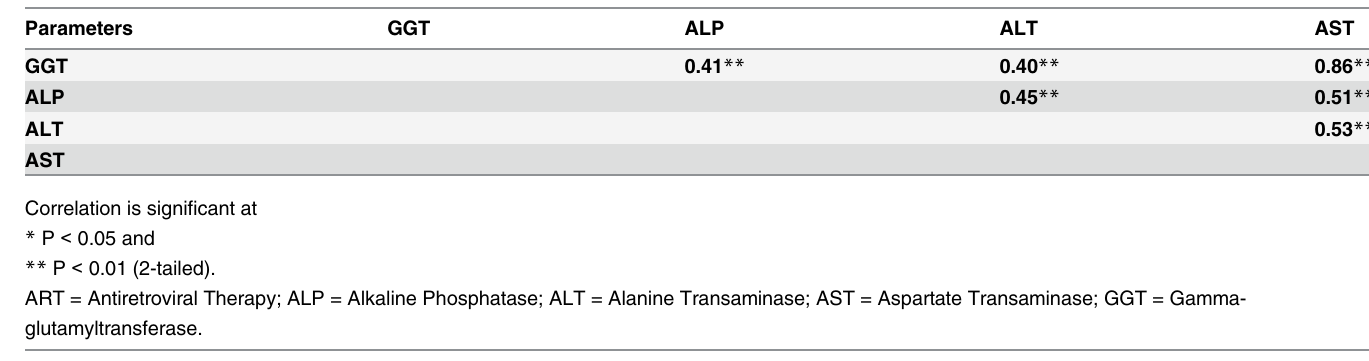
Conversely, each of the enzymes is likely to rise concurrently with the rise of another. Duration